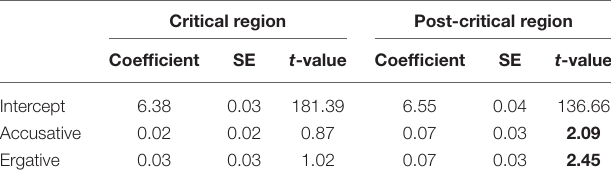
TABLE 9 | Lmer results for reading time at the critical (non-finite verb) and the post-critical region for Experiment 3. The analysis uses treatment contrast, with the Locative condition as the baseline with the coefficient signifying the difference from the baseline.